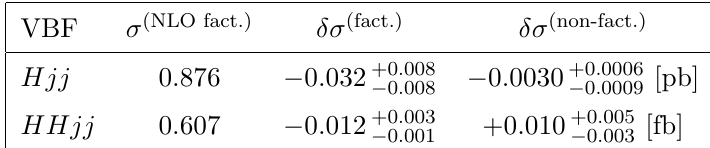
VBF (cid:27) (NLO fact.)